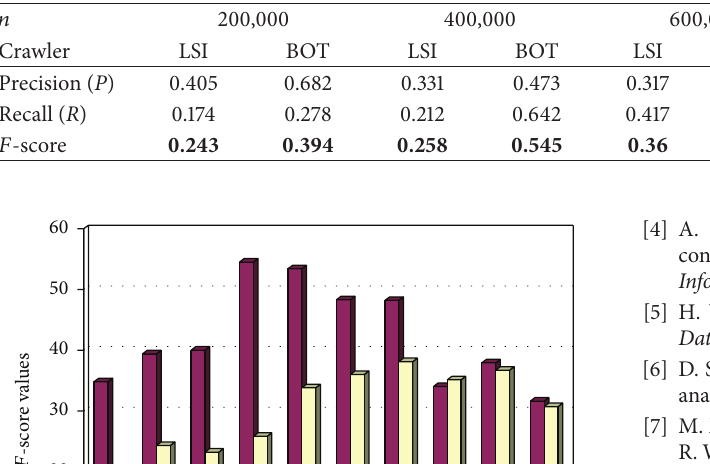
Table 3: Recall, precision, and 𝐹 -score value comparison.